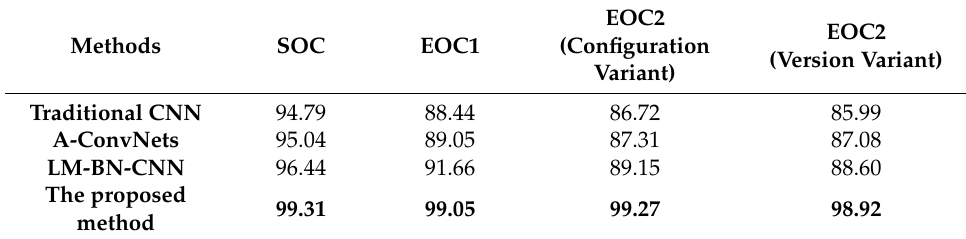
Table 10. Comparison of different